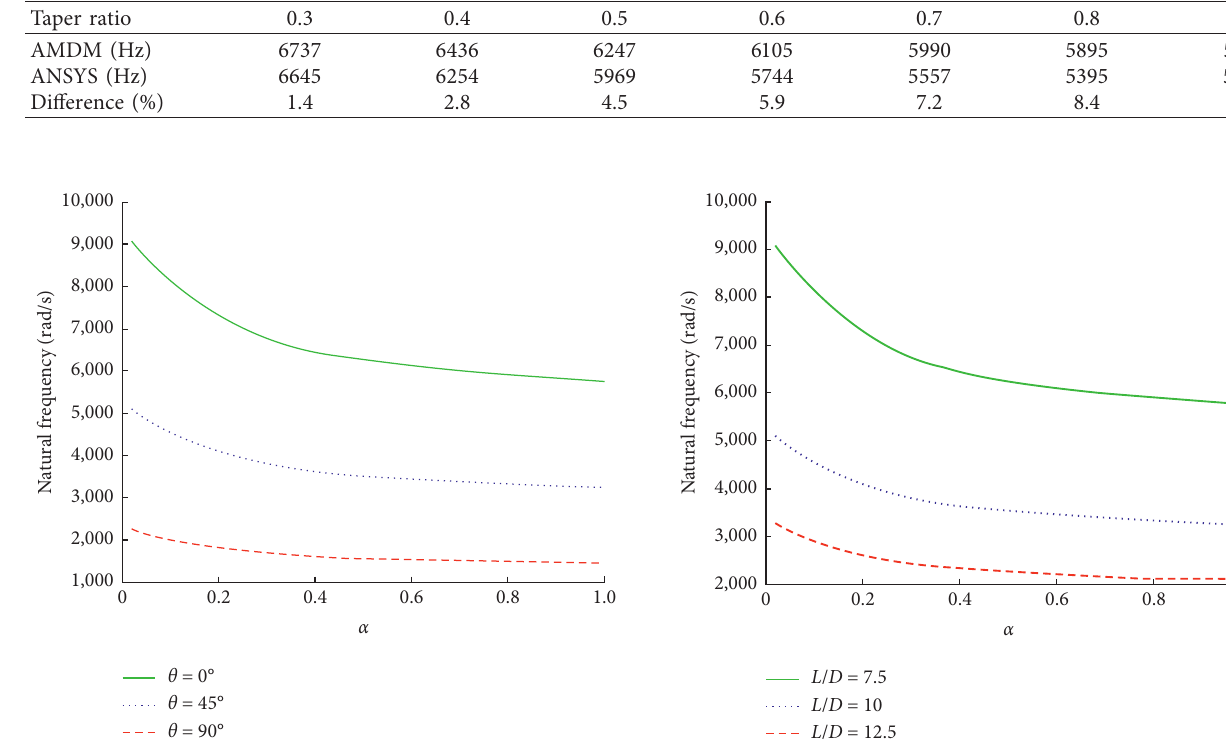
Figure 3: Natural frequency of the tapered composite boring bar with different ply angles.